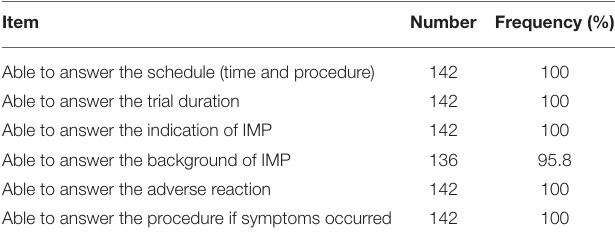
TABLE 3 | Understanding of informed consent form ( n = 142).